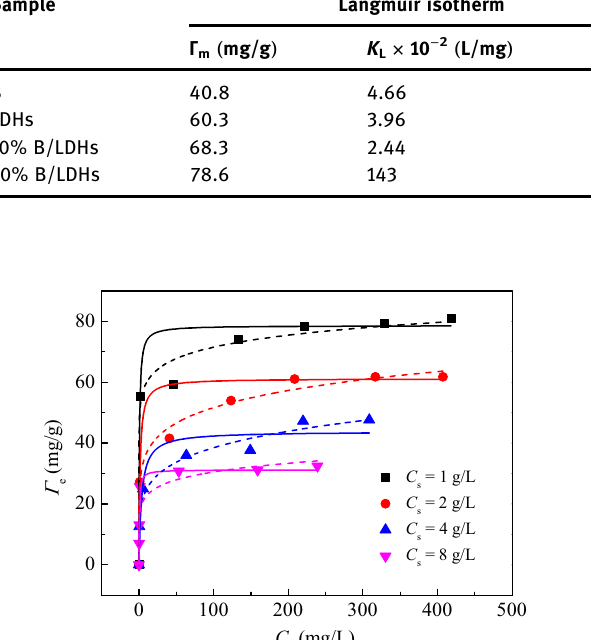
Table 2: Nonlinear - fi t data of model parameters for Pb ( II ) sorption on B, LDHs, and B/LDHs samples Sample